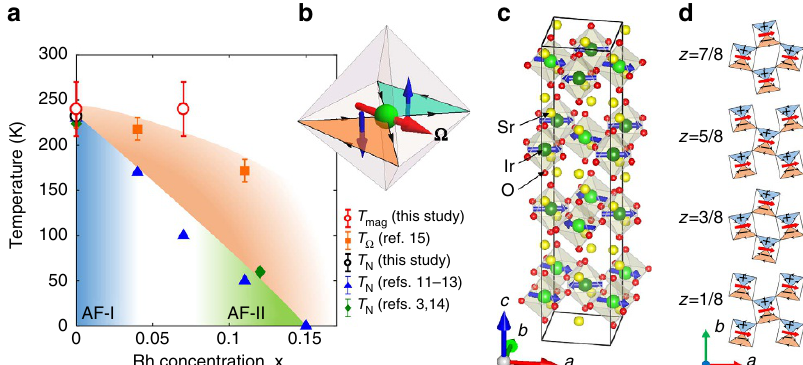
Figure 1 | Magnetic phase diagram and LC order. ( a ) Magnetic phase diagram of Sr 2 (Ir,Rh)O 4 . The obtained transition temperatures, T N and T mag in this study are represented by black and red empty circles for the conventional AFM and the hidden magnetism preserving the lattice translation, respectively. The hidden broken symmetry phase, T O , observed by SHG 15 (orange squares) is also represented as well as the AFM phase determined by magnetization measurements 11–13 (blue triangles) and by neutron diffraction 3,14 (green diamonds). ( b ) A schematic picture for co-planar LC state in a single IrO 6 octahedron. The blue and red arrows denote magnetic moments generated by circulating currents and the anapole, O , respectively. ( c ) Atomic and AFM structures of Sr 2 IrO 4 with a space group I 4 1 / a (origin choice 2) (Ir atoms are represented in green, Sr in yellow and oxygen in red). ( d ) The co-planar LC ordered state in the basal plane. The red arrows denote the anapole vector, X , as shown in b , and the plus/minus signs correspond to the orbital magnetic moments perpendicular to the ab -plane. This nearly-ferro-toroidal order preserves translational symmetry of lattice but breaks parity inversion, four-fold rotational and time-reversal